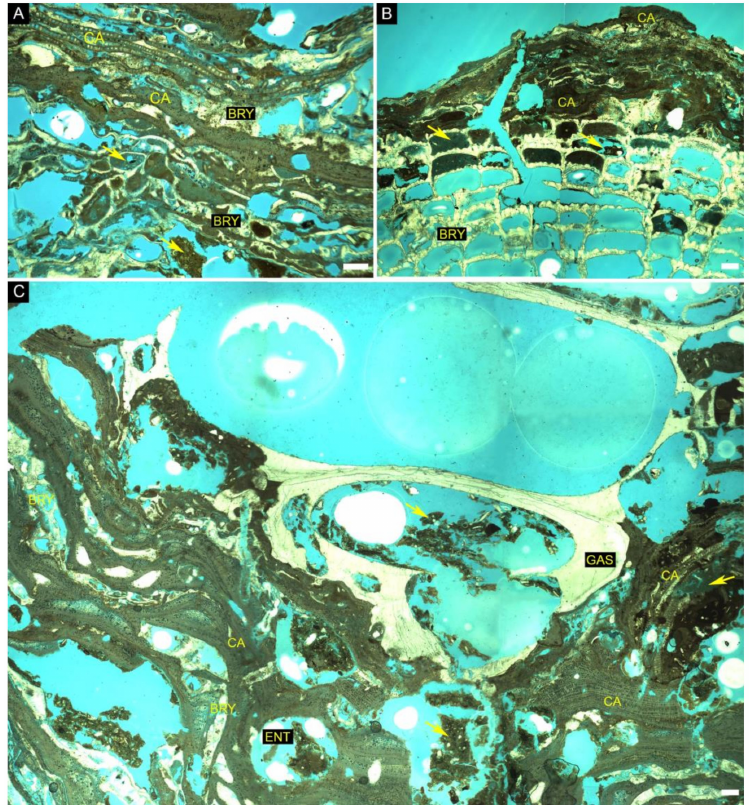
Figure 10. Thin-section images of rhodoliths from the south sector of the SEAL Basin. ( A ) Inner portion of a rhodolith sample 5 from site 5 (at 47 m depth) formed by coralline algae (CA) and bryozoans with some voids filled by micrite (yellow arrow); ( B ) Outer portion of a rhodolith sample 7 from site 6 (at 54 m depth) with bryozoan (BRY) in the nucleus covered by coralline algae (CA) with some voids filled by packstone rich in micrite (yellow arrow); ( C ) Rhodolith sample 10 from site 7 (at 50 m depth) with gastropod shell (GAS) in the nucleus covered by coralline algae (CA) and bryozoan (BRY) with some voids partially filled by wackestone (yellow arrow). Scale bars = 200 µ